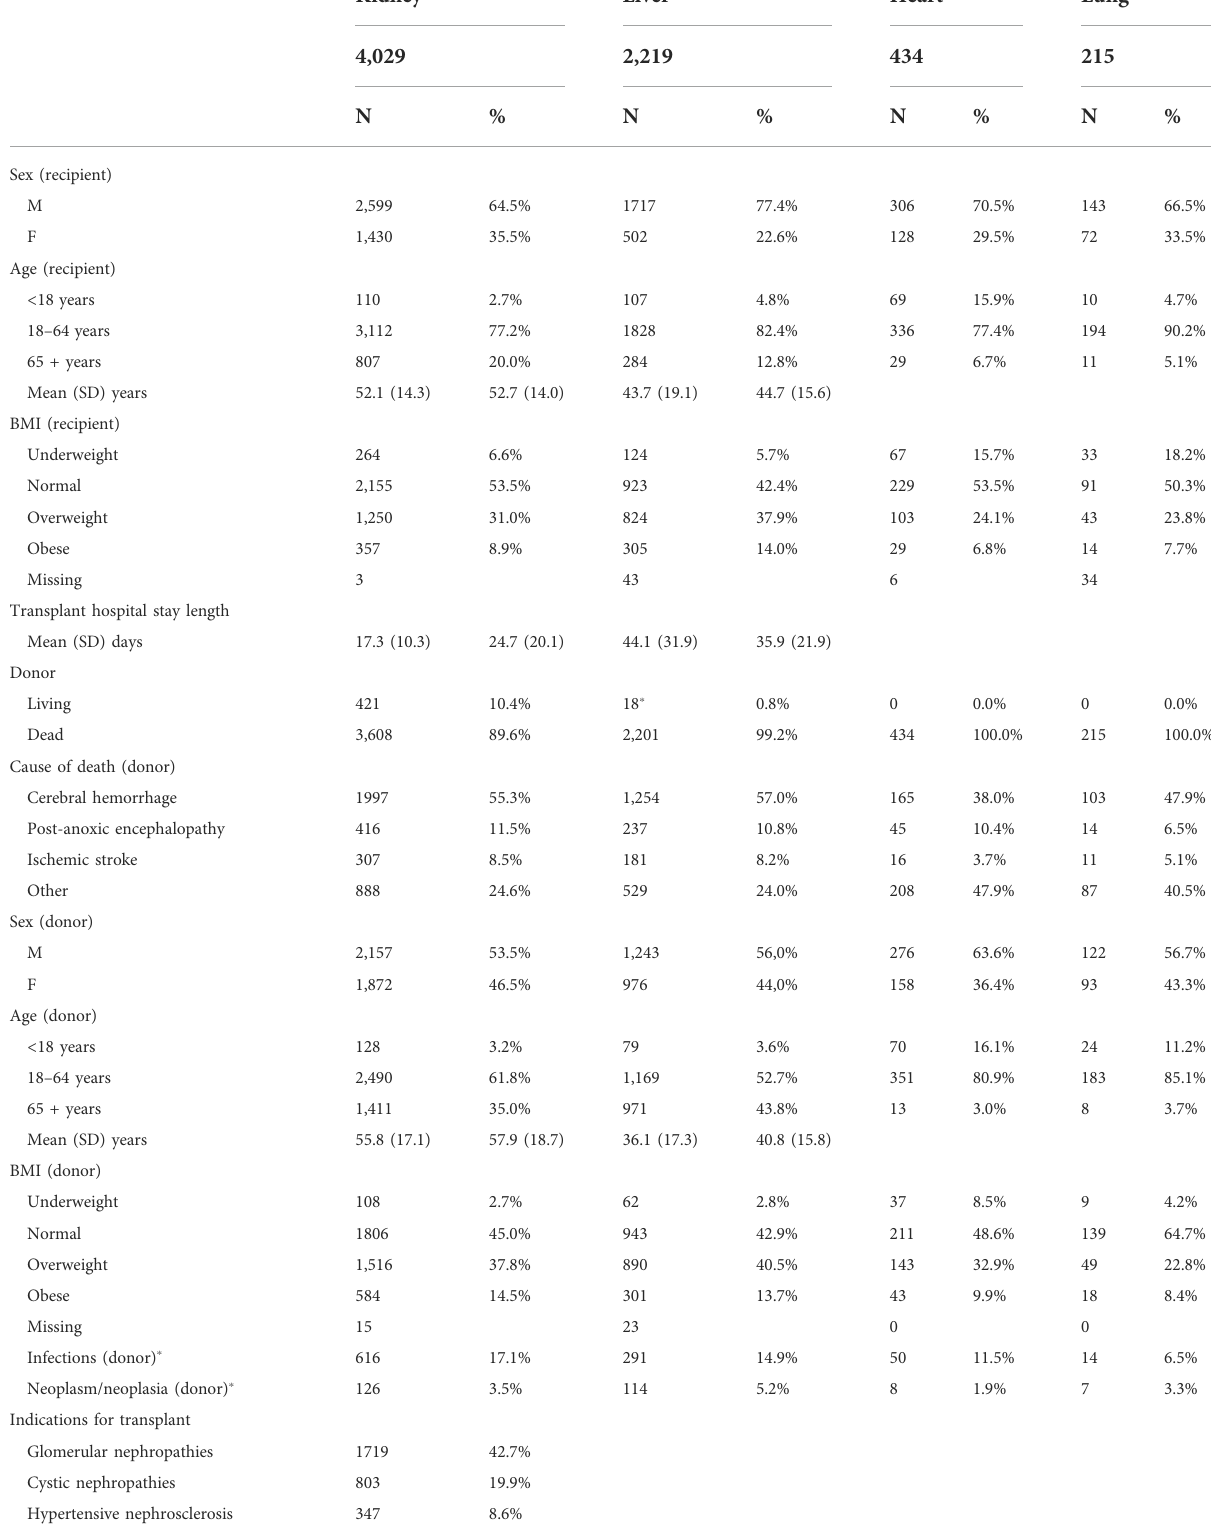
TABLE 1 Demographic and clinical characteristics of donor and recipient by type of organ